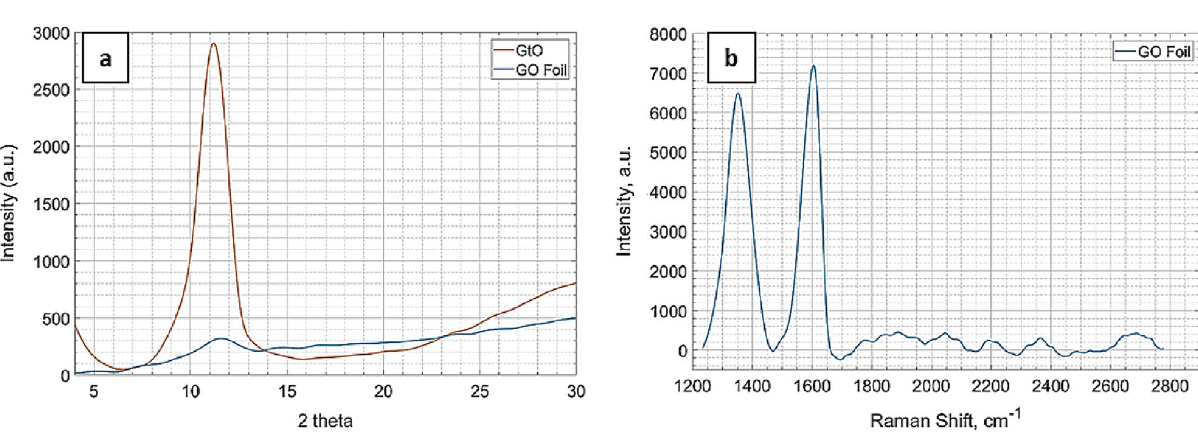
Figure 8. ( a ) XRD patterns of GtO powder and GO Foil. ( b ) Raman spectra of the GO